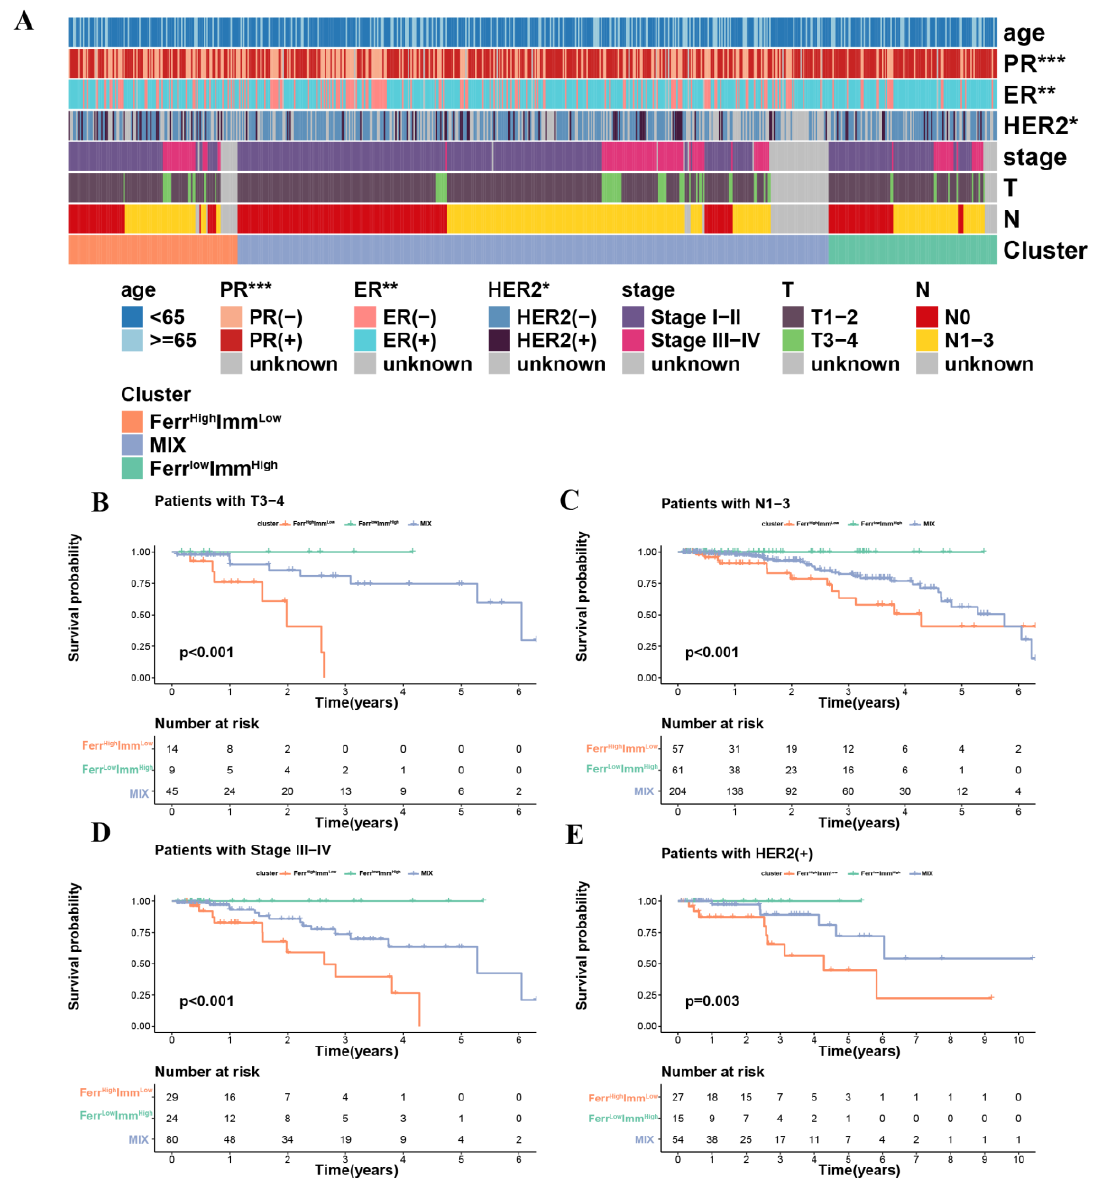
Figure 3. Differences in clinical characteristics and clinical stratified survival analysis among the three subtypes: ( A ) Heatmap of clinical features between subtypes. ( B – D ) The difference in OS between three groups stratified by stage. ( E ) The difference in OS between three groups stratified by HER2. (* p < 0.05; ** p < 0.01; *** p < 0.001).